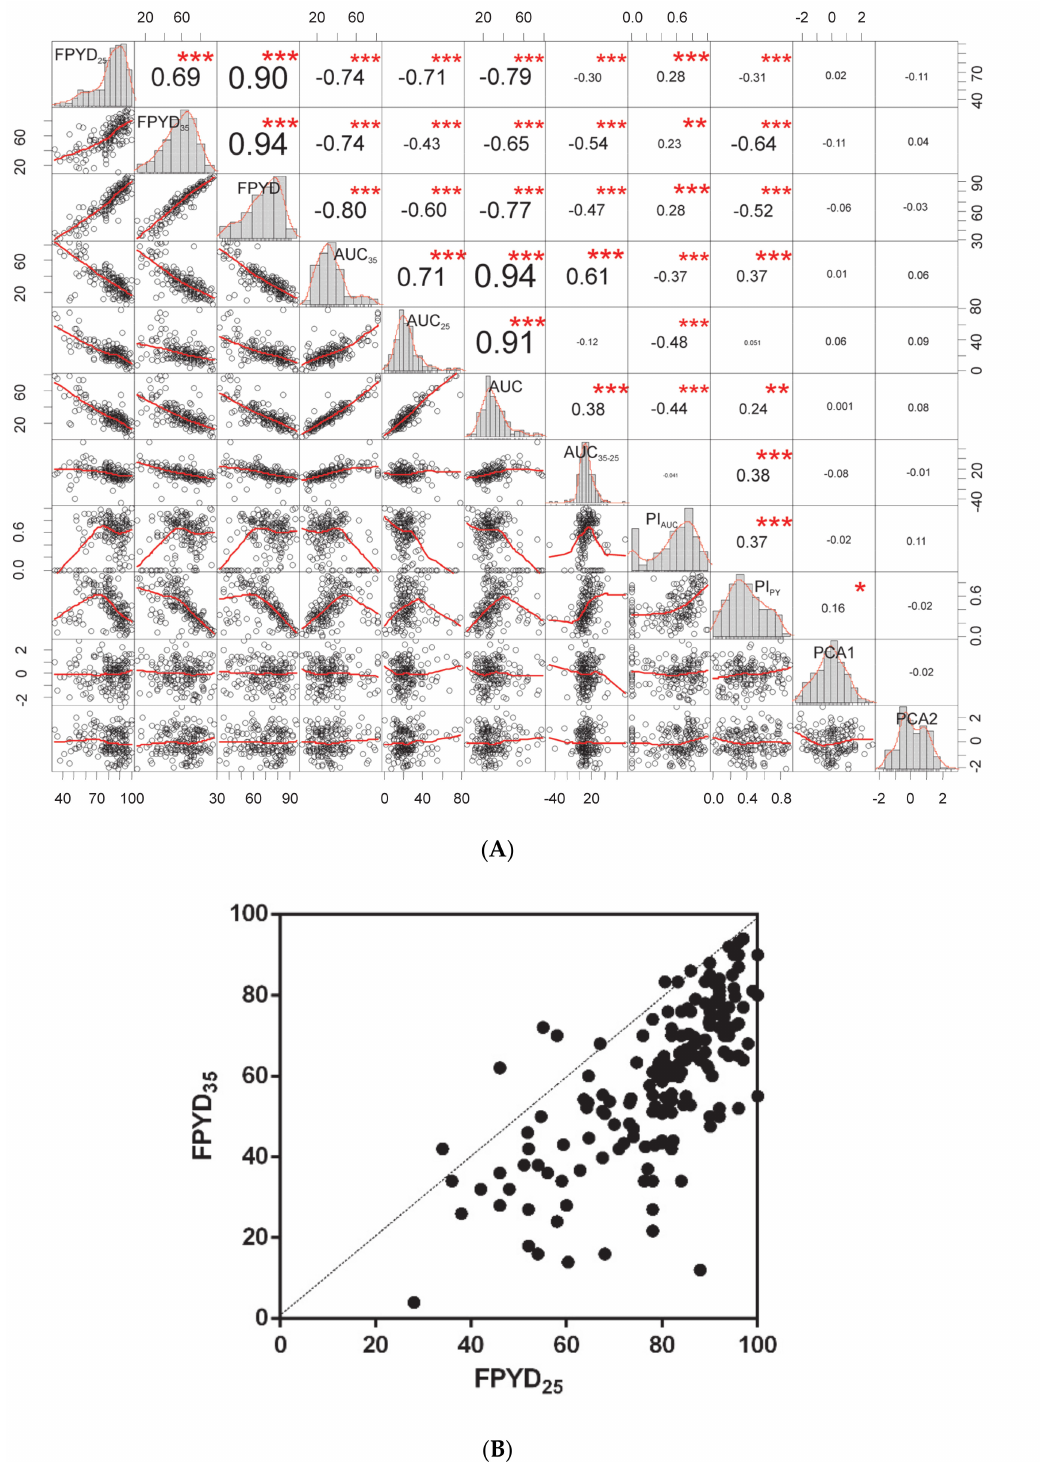
Figure 1. Correlations among dormancy release traits. ( A ) Correlation chart of dormancy release traits and ordination scores of environmental principal component analysis, PCA (first two ordination axes; PCA1, PCA2; see Figure 2A,B). The distribution of each variable is shown on the diagonal. Bellow the diagonal the bivariate scatter plots with a fitted smooth line (loess) are displayed. Above the diagonal the value of the Pearson correlation coe ffi cient plus the significance level as stars are displayed (* p ≤ 0.05, ** p ≤ 0.01, *** p ≤ 0.001). ( B ) Relationship between final physical dormancy (PY) dormancy of each accession under two temperature treatments (FPYD 35 and FPYD 25